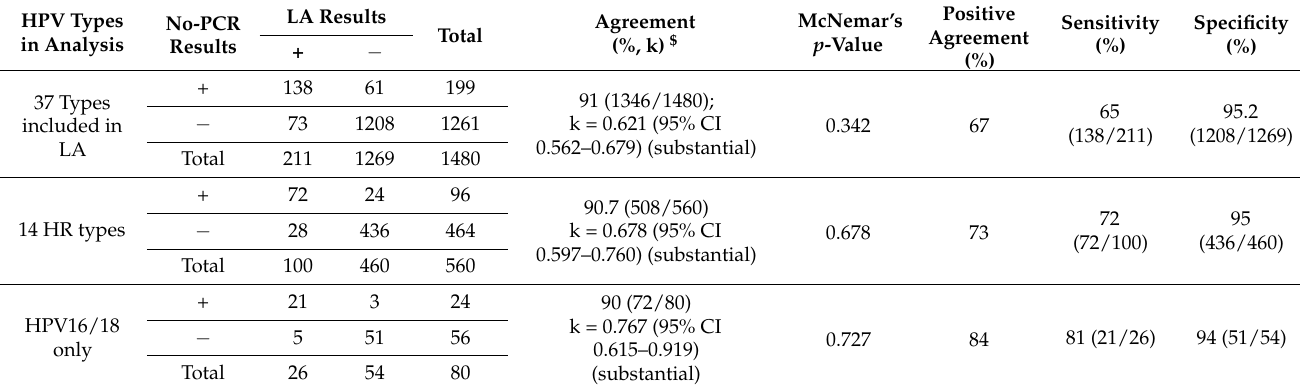
Table 1. HPV type-specific concordance between No-PCR and